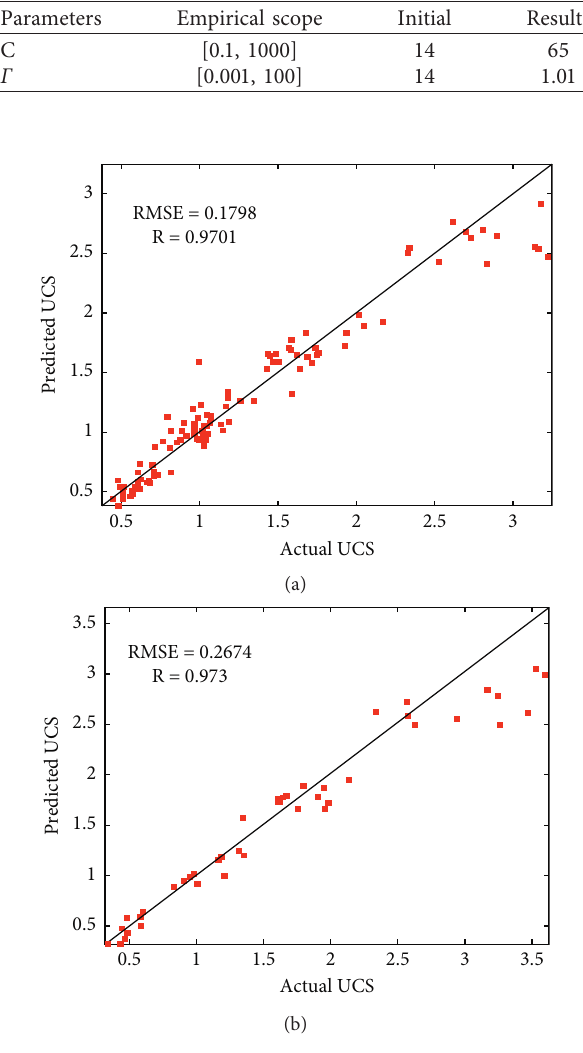
Figure 6: Comparison of UCS values. (a) Training dataset. (b) Testing dataset.